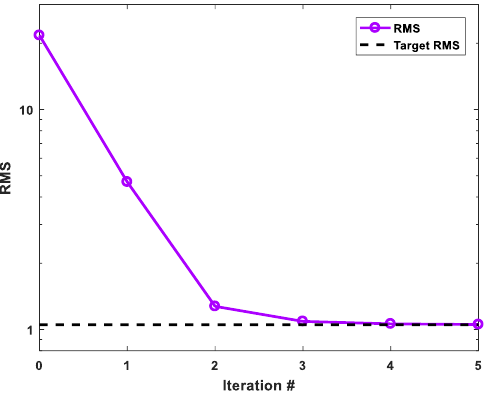
Figure 19. Convergence plot for the isotropic and anisotropic blocks model with topography. The black dashed line indicates the threshold RMS.